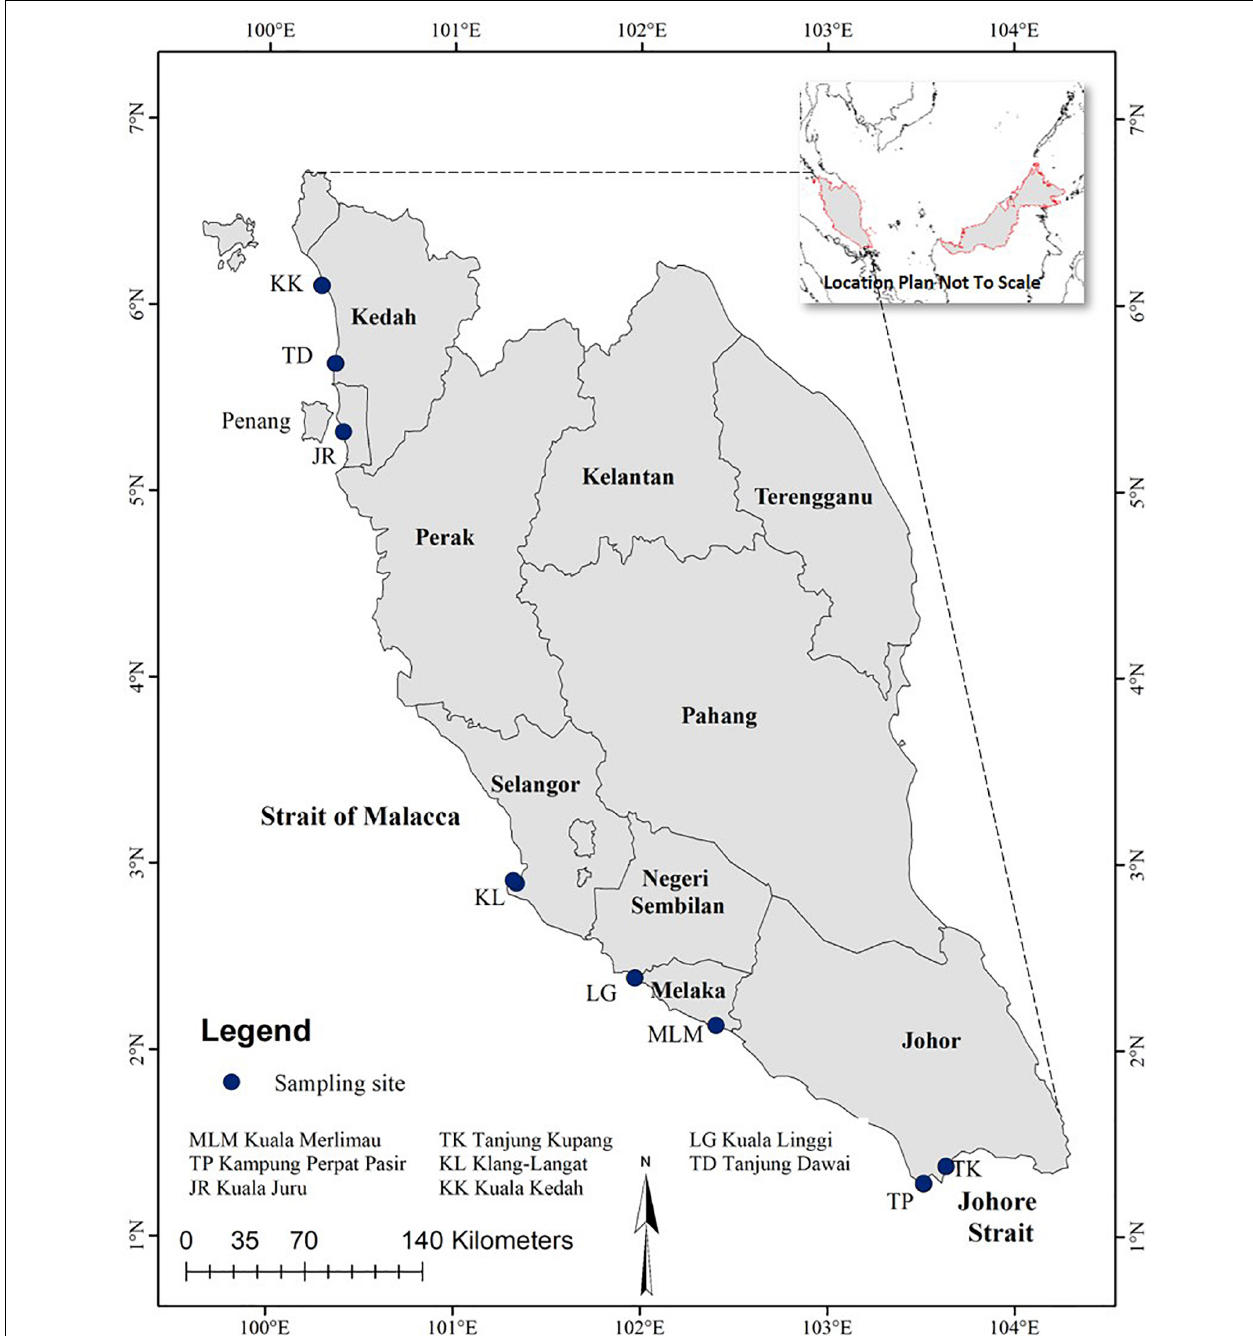
FIGURE 1 | Map of Peninsular Malaysia showing the sampling sites where the giant mudskippers were collected.